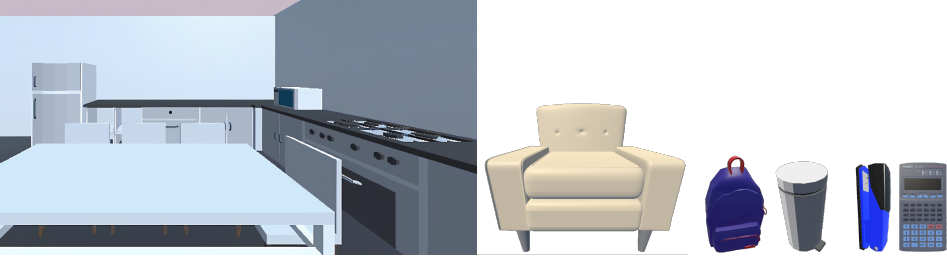
Figure 1. The created 3D home environment with exemplary corresponding objects, one from the large size and two from the medium size and two from the small size groups, chosen based on prestudy survey results.